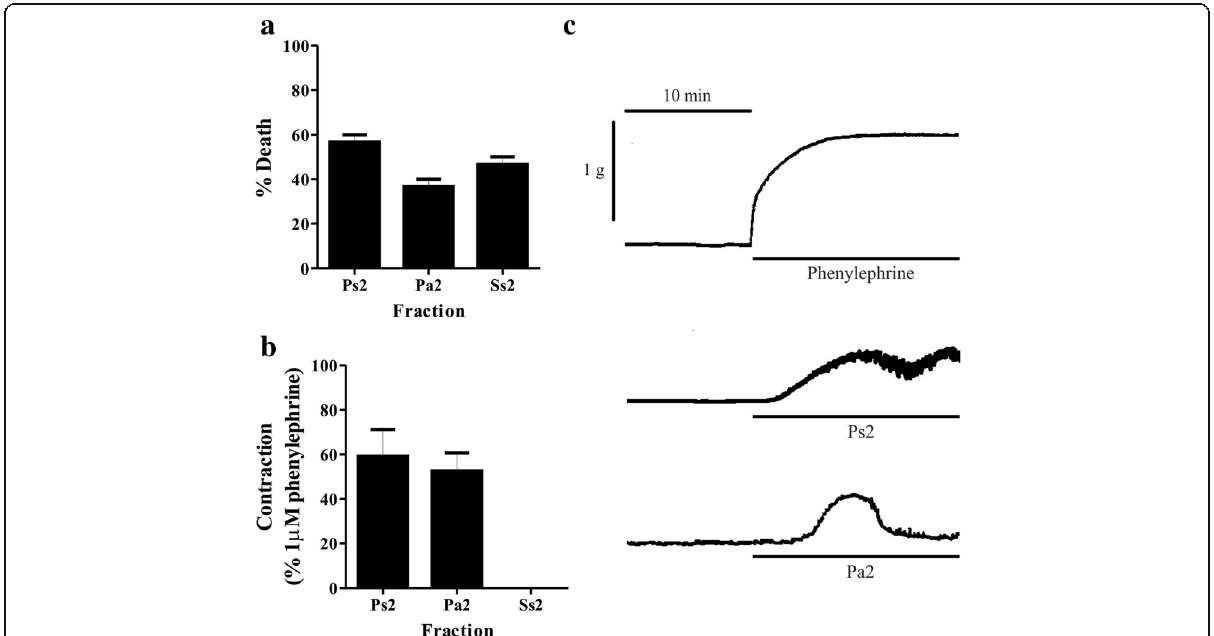
Fig. 9 Biological activities of the low-molecular-weight fractions obtained from the aqueous extracts. a Toxicity to crickets ( A. domestica ), 24 h post-injection, at a concentration of 50 μ g of lyophilized powder/g. b Vasoconstrictor activity on isolated rat aortic rings at a concentration of 1000 μ g of lyophilized powder/mL. c Representative recordings showing the vasoconstrictor activity of the fractions (1000 μ g/mL) compared with the activity induced by phenylephrine (1 μ M)